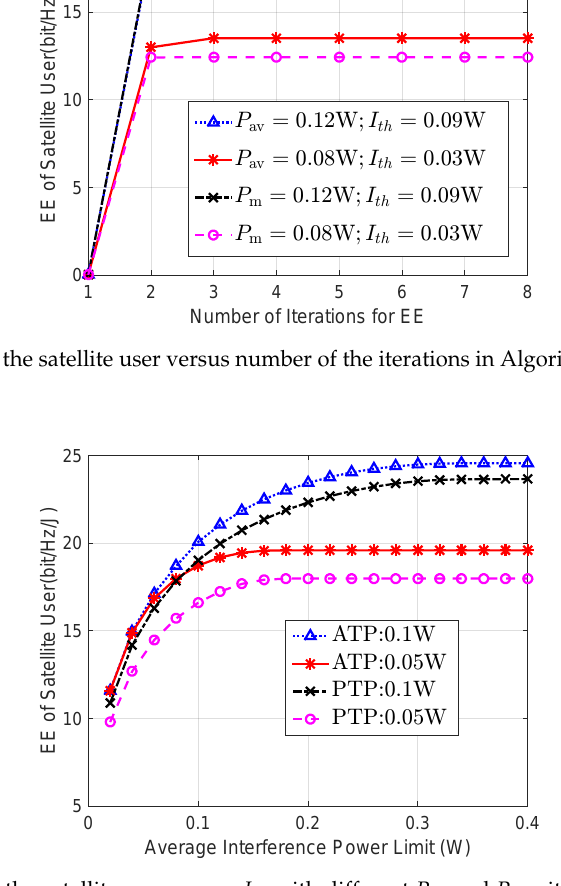
Figure 3. The EEs of the satellite user versus I th with different P av and P m with m I = 1 and Ω I = 1.